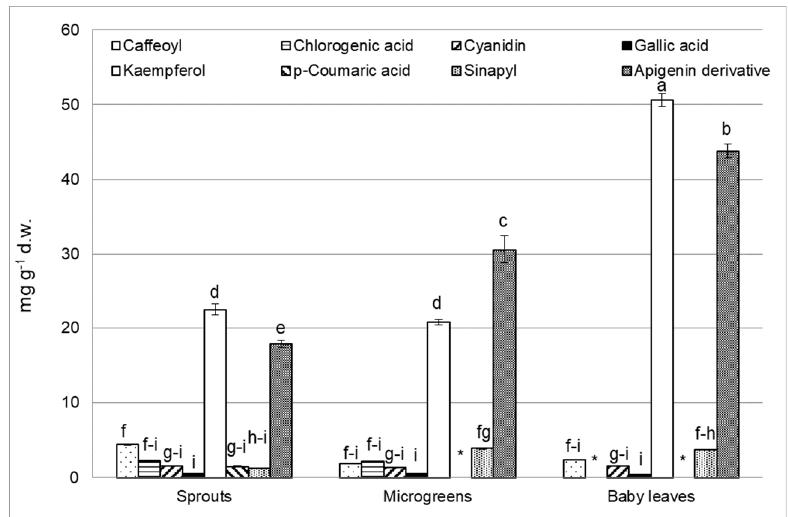
Figure 3. Polyphenol compounds for BN at different growth stages. Data are reported as mean ± S.E. Bars with the same letters are not significantly different, as determined by Tukey’s test (p < 0.05). Symbol * = not detected compound.